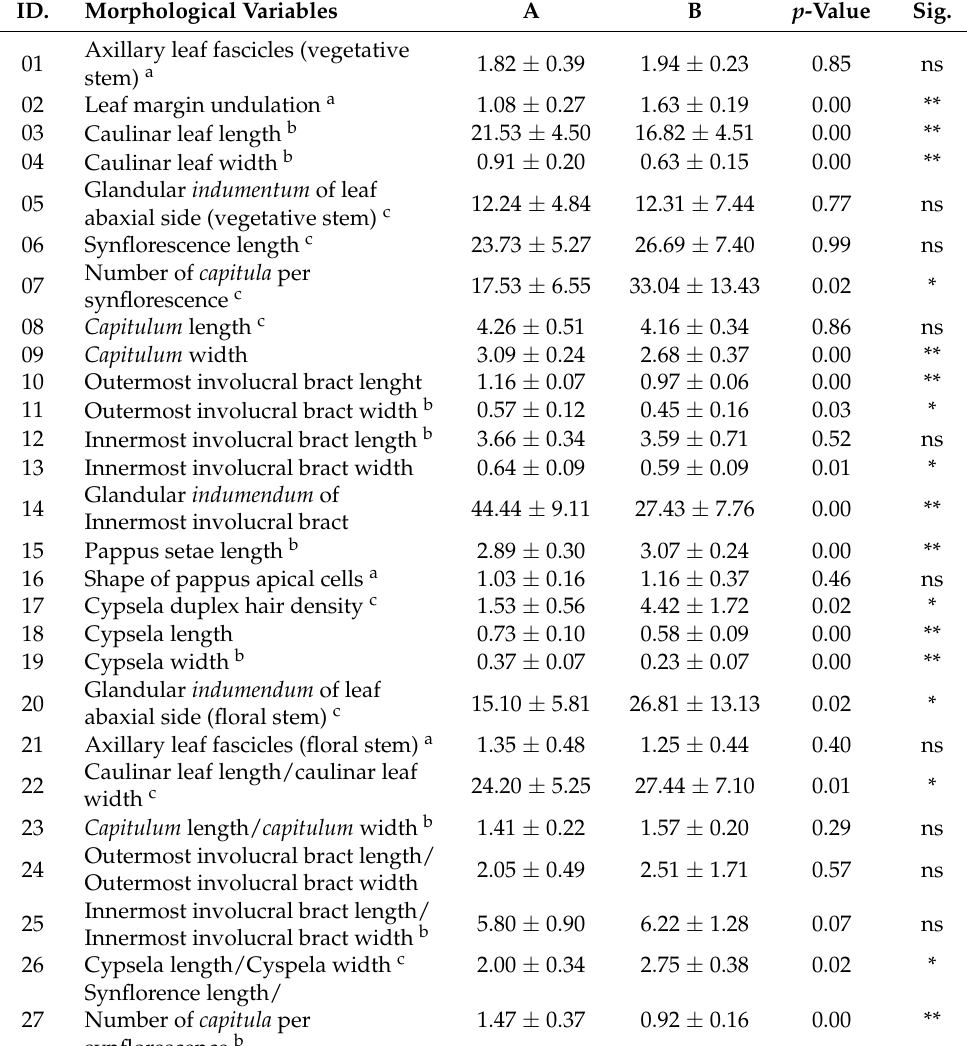
Table 1. Morphological characters of two wild populations of Helichrysum spp. ( H. litoreum and H. italicum subsp. italicum ) from the Tuscan Archipelago (Central Italy). ID is the Identification number of the single morphological variables; A and B represent the population of the two species, respectively.